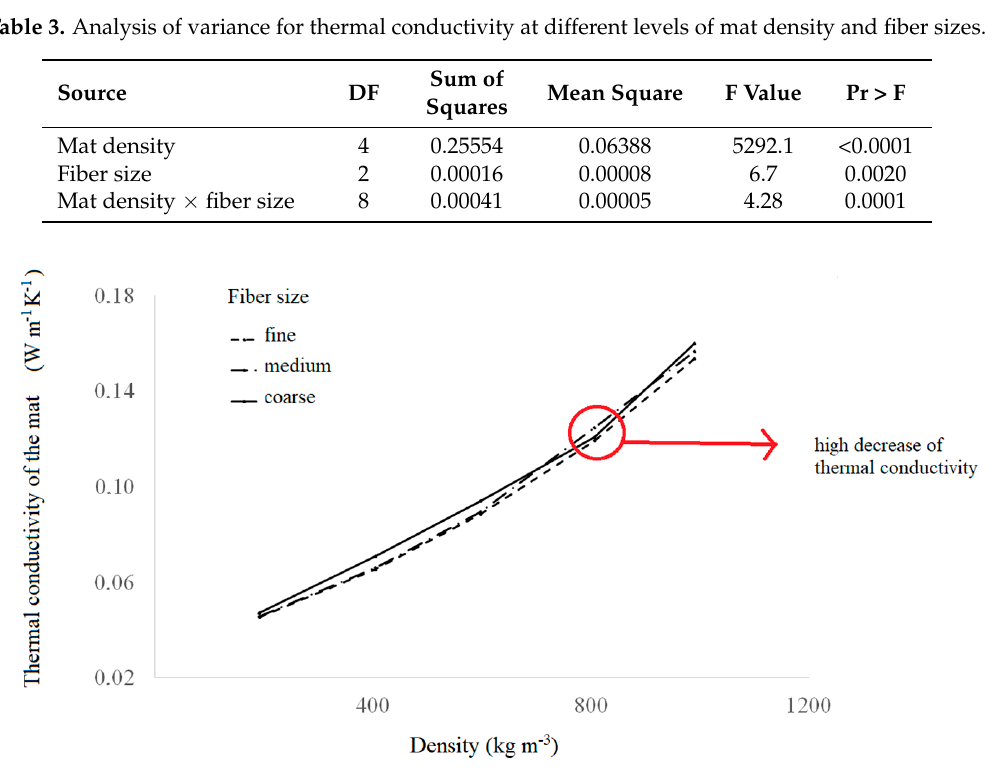
Table 3. Analysis of variance for thermal conductivity at different levels of mat density and fiber sizes.